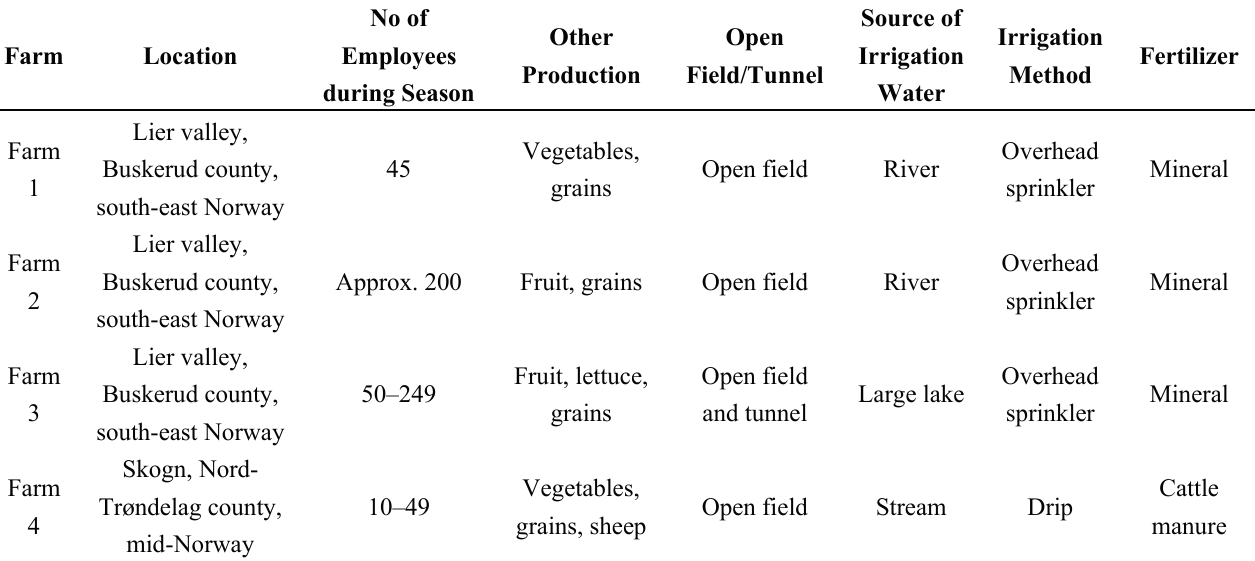
Table 1. Information on the farms participating in the present